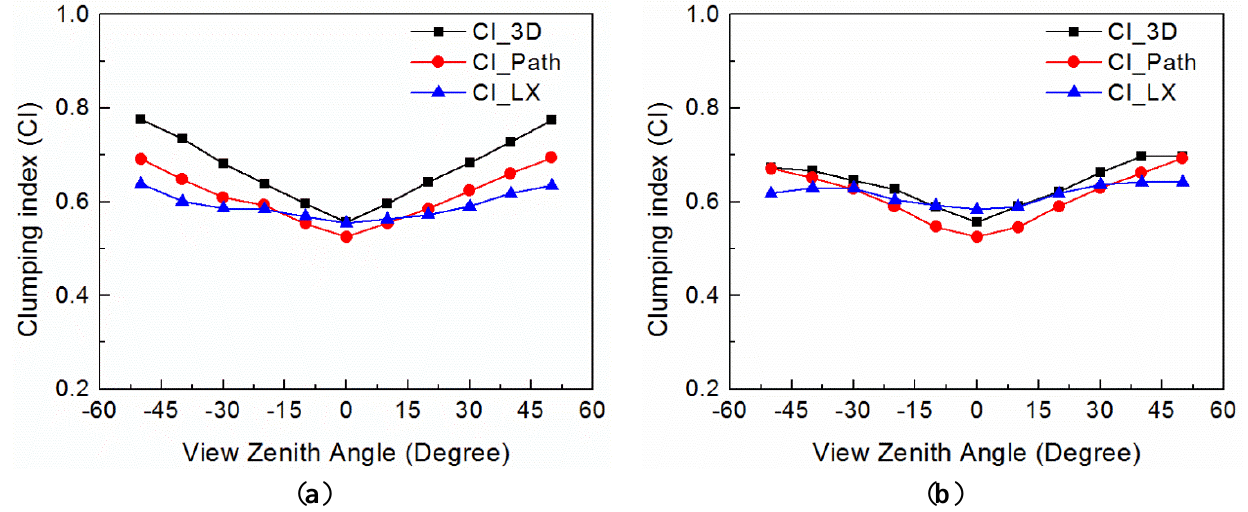
Figure 7. The clumping index (CI) estimated by the path length distribution-based method in this study (CI_Path) and the LX method (CI_LX), compared with the 3D reference values (CI_3D) in the principal plane ( a ) and in the cross plane ( b ).